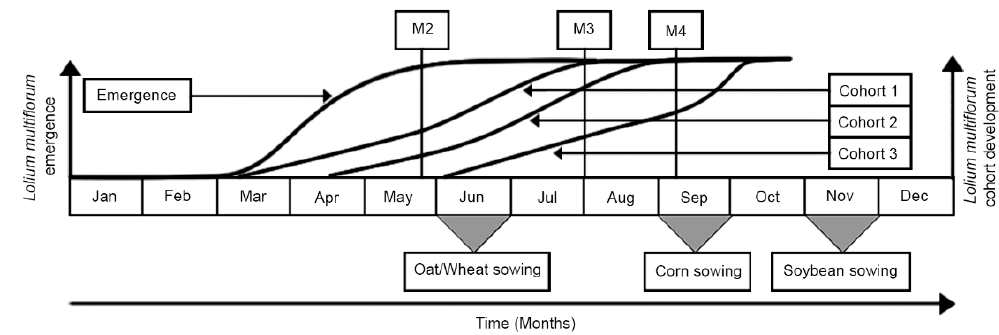
Figure 3. Diagram used to describe L. multiflorum management strategies. The emergence flow and development of each cohort are described in this work, while the crops sowing is adjusted according to Galvan et al., (2015) [31].